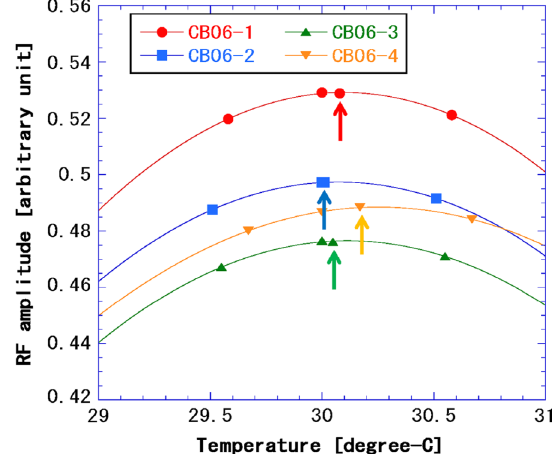
FIG. 8. Amplitudes of the SLED outputs as a function of the cavity temperature in four sets of C -band accelerator units: CB06-1, CB06-2, CB06-3 and CB06-4. The lines are a quadratic curve fit. The arrows represent the optimum temperature point.